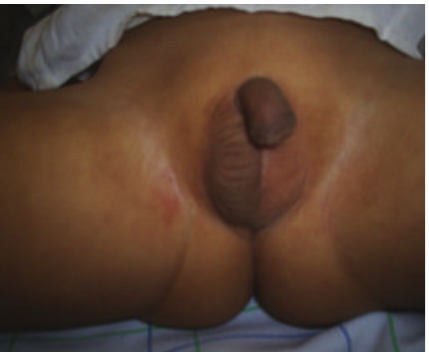
Figure 4: Case 2: nonpalpable left testicle and prepubertal right testicle in scrotal